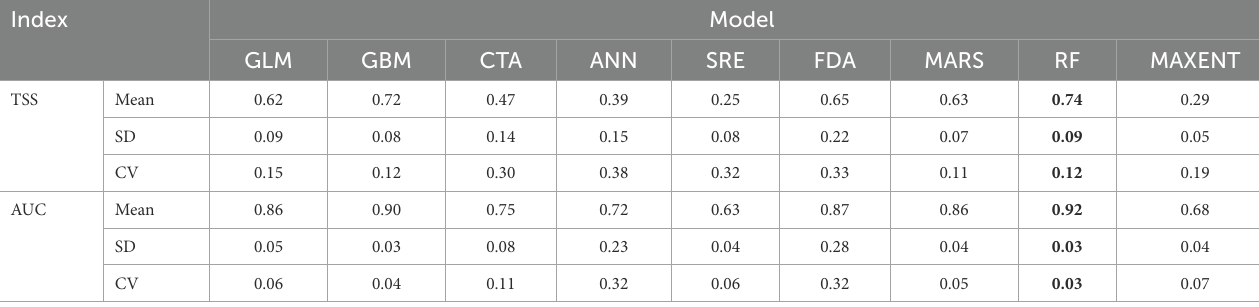
TABLE 2 Performance of each niche model.